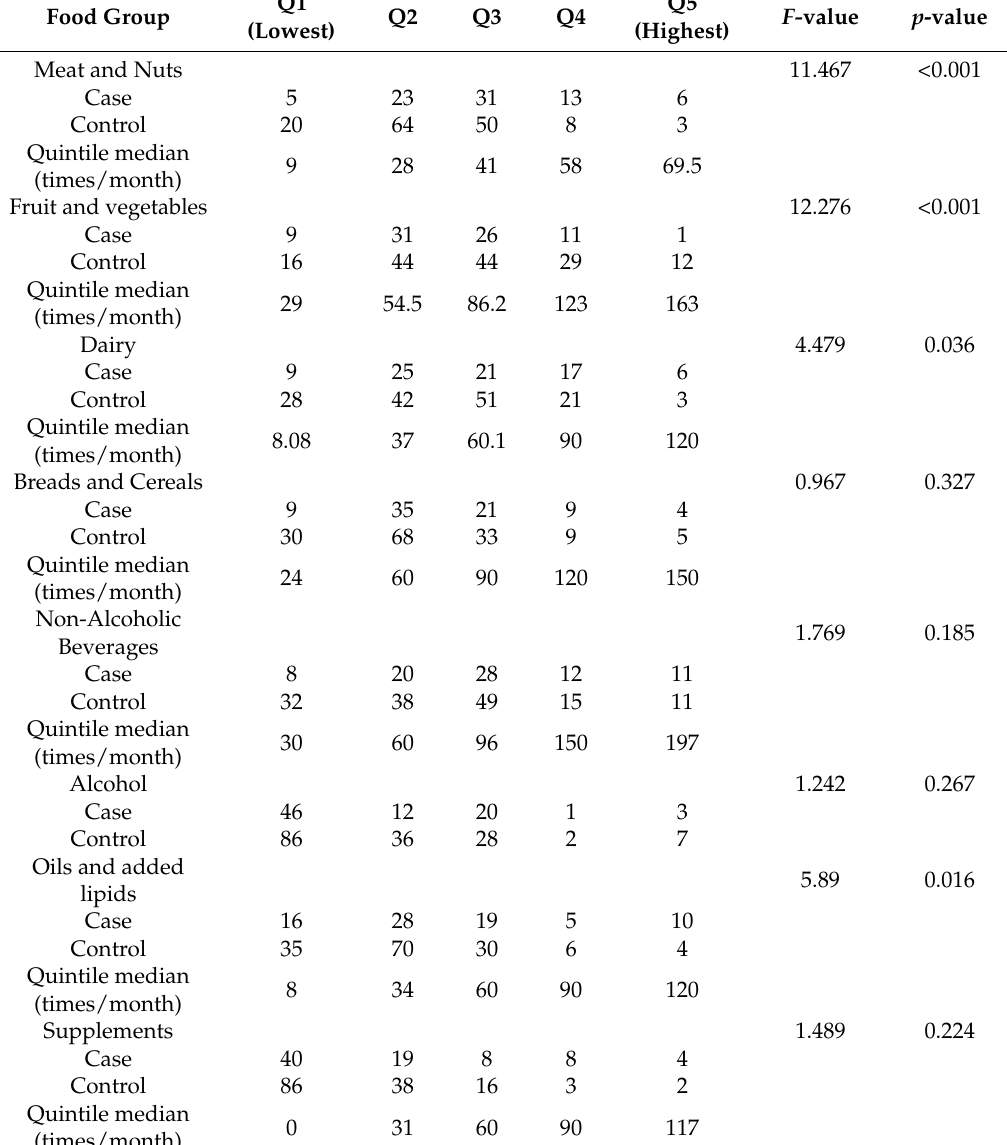
Table 2. Distribution of 42 cases with either glaucoma, age-related macular degeneration, cataracts, or a combination of the three, and 149 control subjects, by monthly frequency of consumption of various food groups. The quintiles spread of participants are shown in Q1 to